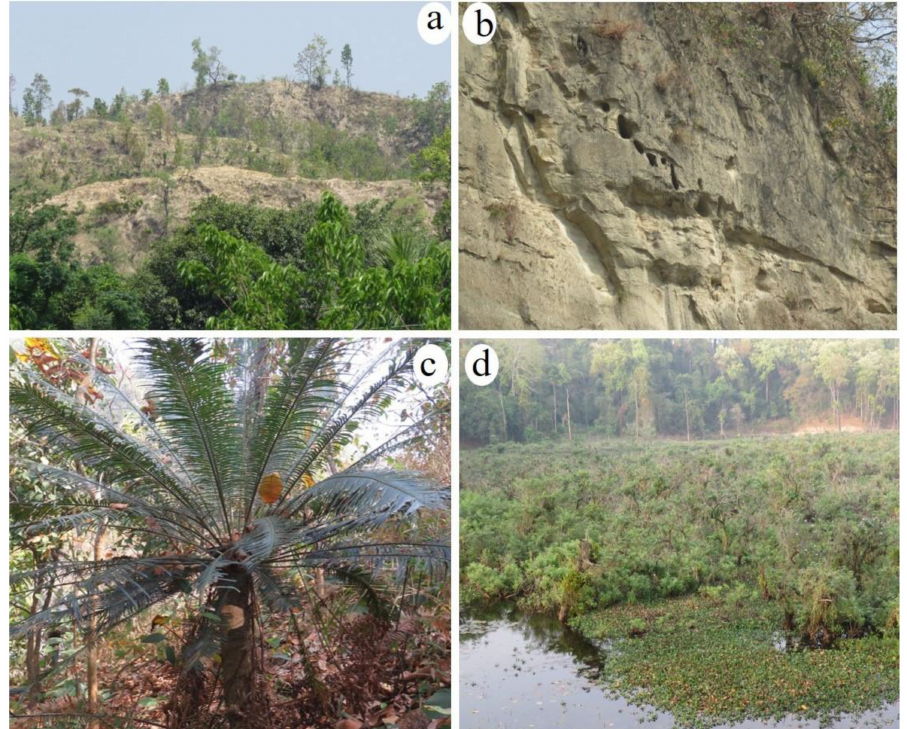
Figure 5. One of the most degraded sites in Chure ( a ), young and fragile deposits in Chure as nesting sites ( b ), endangered Cycas pectinata ( c ), freshwater swamp forests of Cephalanthus tetrandra ( d